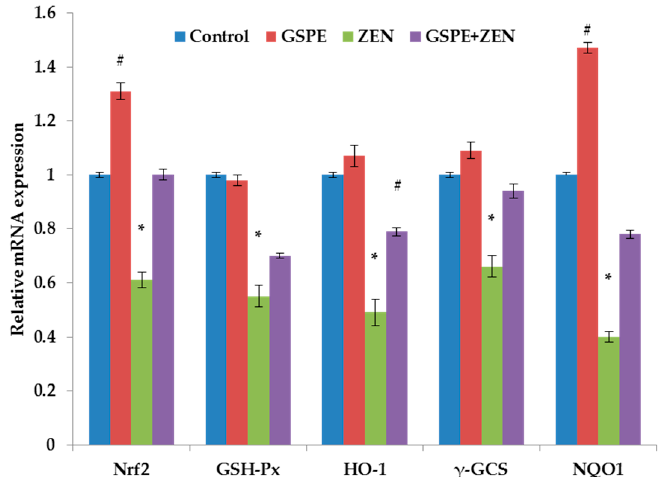
Figure 2. Pretreatment effects of GSPE on ZEN-induced the relative mRNA expression of the nuclear erythroid2-related factor2 (Nrf2), glutathione peroxidase (GSH-Px), hemeoxygenase-1 (HO-1), γ -glutamyl cysteine synthetase ( γ -GCS), and quinone oxidoreductase 1 (NQO1) in the liver of mice. Values are mean ± SEM of ten mice in each group. * p < 0.05 vs. control group, # p < 0.05 vs. ZEN-treated group.